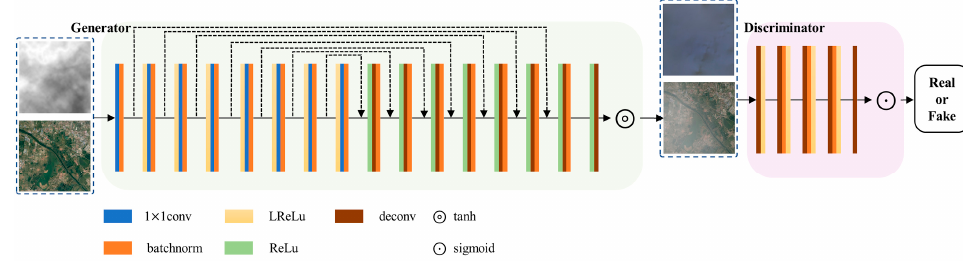
Figure 2. UGAN structure.